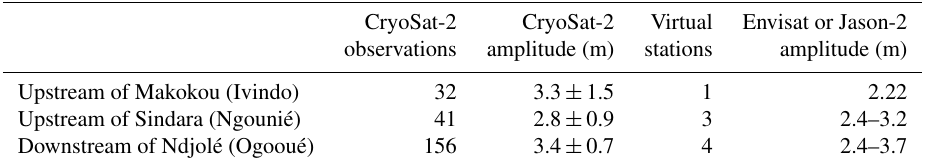
Table 1. Comparison of CryoSat-2 and Envisat or Jason-2 water height amplitudes for three branches of the Ogooué with sufficiently dense CryoSat-2 observations. The dispersion of the amplitudes predicted by CryoSat-2 are given by the standard deviation for the given river